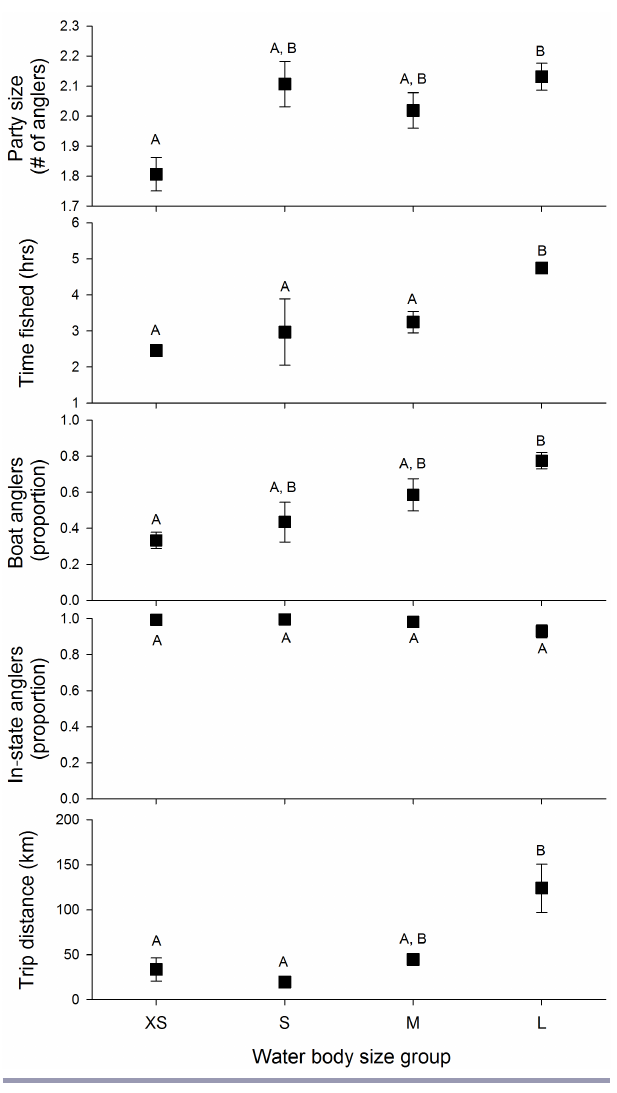
Fig. 2 . Party attribute differences (± SE) among water body groups (XS = extra small, S = small, M = medium, L = large) for party size, time fished, boat anglers, in-state anglers, and trip distance. Different letters indicate significant differences among water body groups for each attribute as indicated by separate univariate ANOVA’s and post-hoc Tukey HSD tests (conversely same letters = no significant